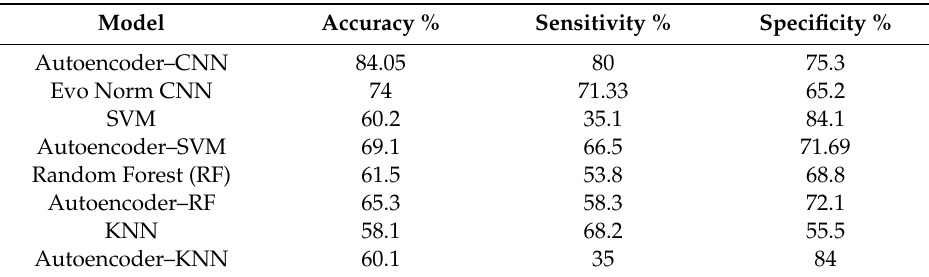
Table 1. Sensitivity and specificity.